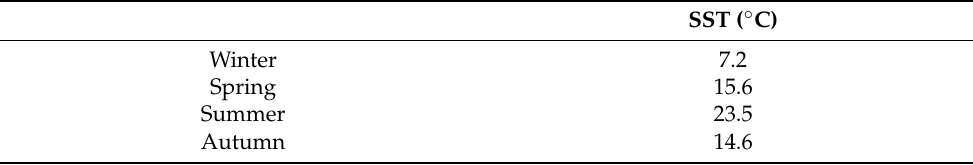
Table 1. Regional processing parameters for the SST in the C2RCC